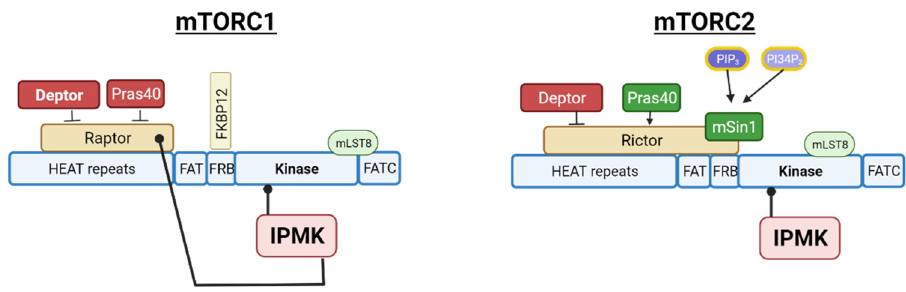
Figure 5. Diagram of mTORC1 and mTORC2 interactions with IPMK. Schematic diagrams of the mTOR kinase regions with key components of the mTORC1 and mTORC2 complexes. Physical associations of IPMK N-terminus with the mTOR kinase domain and the C-terminus of IPMK with Raptor are indicated by black lines. Created with BioRender.com, accessed on 27 May.